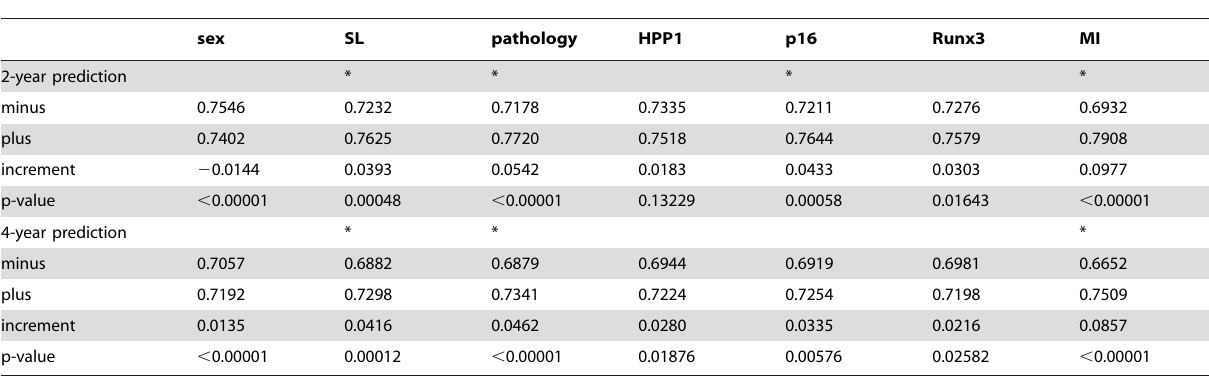
Table 3. Univariate analyses of incremental